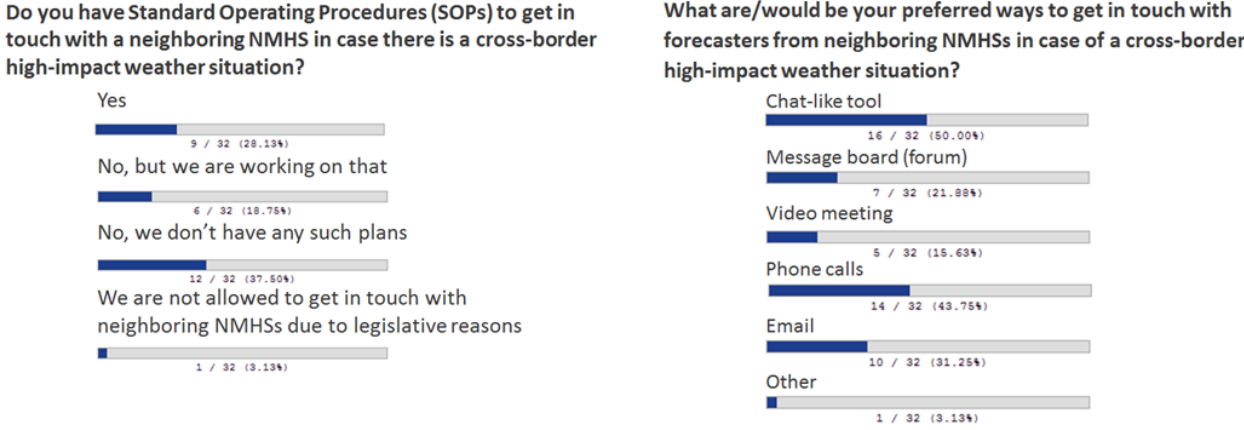
Figure 8. Results on questions regarding collaboration with neighboring NMHSs in case of a cross-border high-impact weather situations. There is room for improvement in establishing SOPs. Most of the operational meteorologists want to get in touch via chat-like tool or via phone call 24h prior to the